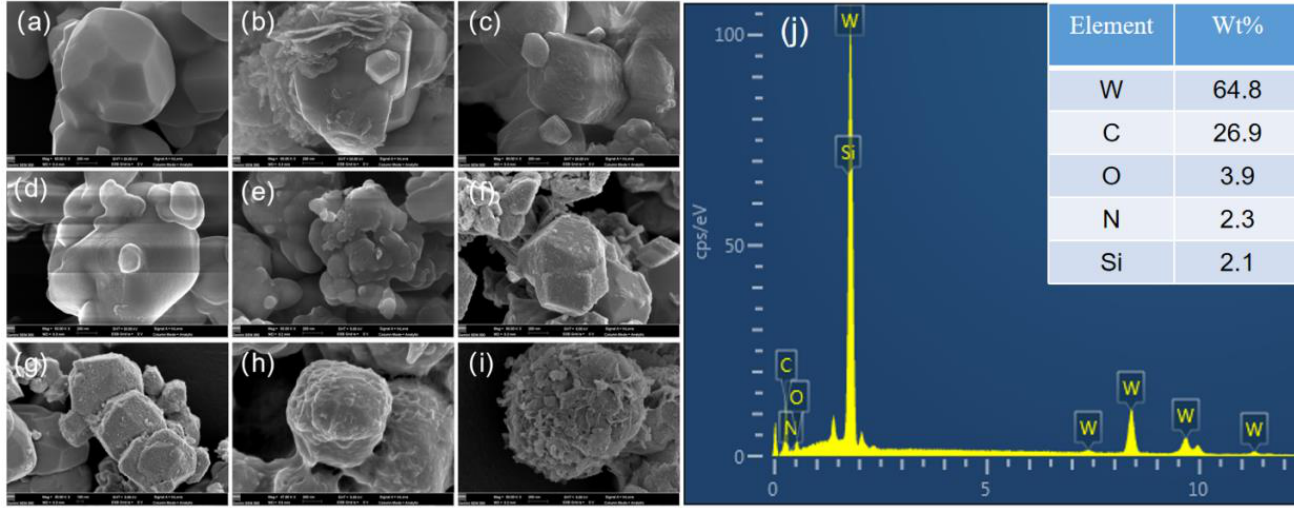
Figure 2. SEM: ( a ) pure W, ( b ) 1 g/L of DA to prepare W/PDA, ( c ) 1.5 g/L of DA to prepare W/PDA, ( d ) 2 g/L of DA to prepare W/PDA, ( e ) 2.5 g/L of DA to prepare W/PDA, ( f ) stirring for 2 h to prepare W/PDA, ( g ) stirring for 8 h to prepare W/PDA, ( h ) stirring for 16 h to prepare W/PDA, ( i ) stirring for 24 h to prepare W/PDA, ( j ) EDS spectra of W/PDA.